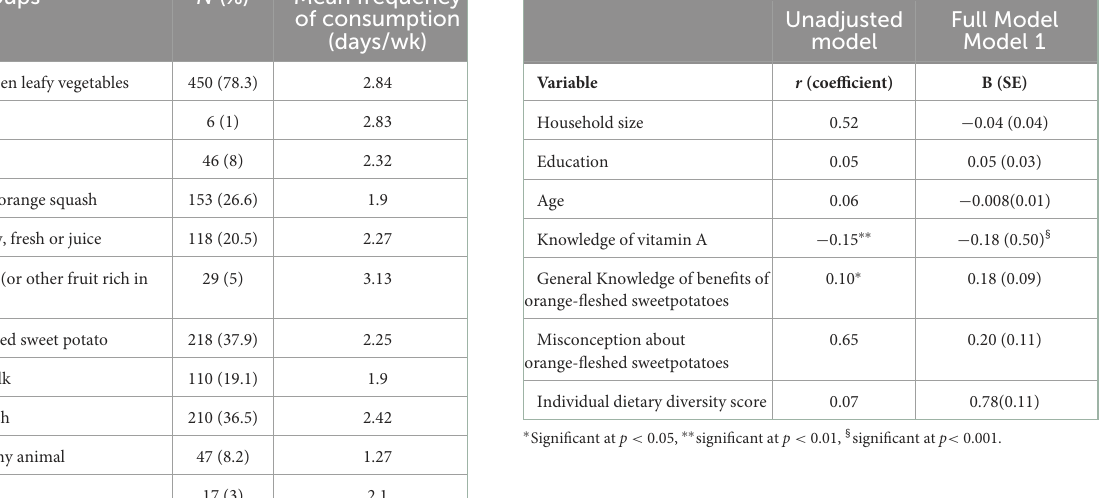
TABLE 6 Vitamin A rich food group groups consumed at least once during the last week and meal frequency for women.